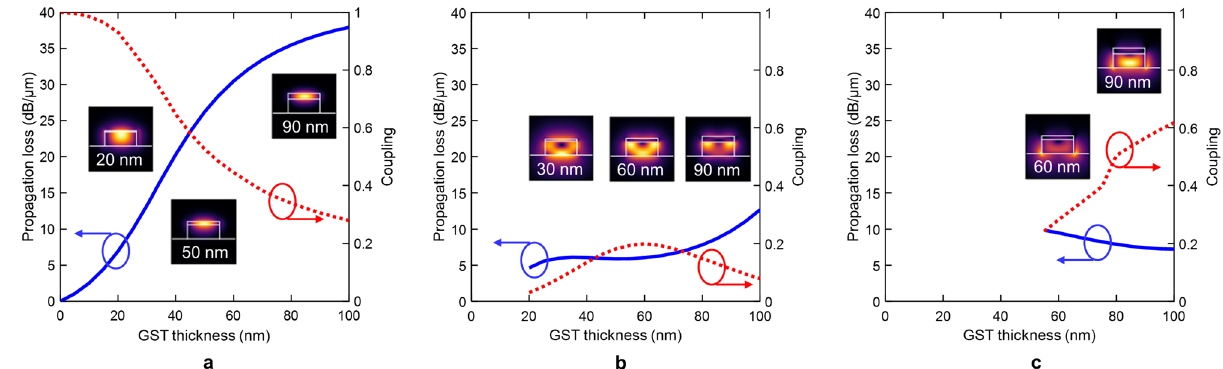
Figure 4. GST crystalline. Propagation losses (solid line) and coupling (dotted line) for the three supported optical modes: ( a ) fundamental GST TE-like (mode 0), ( b ) hybrid (mode 1), and ( c ) Si TE-like (mode 2). Insets show the electric-field distribution | E | for a certain GST thickness.